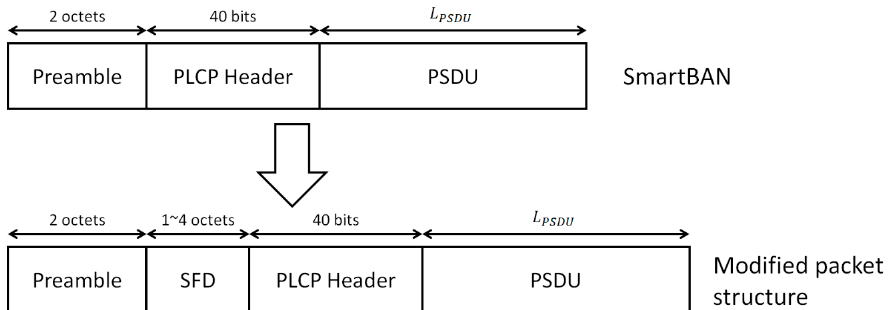
Figure 6. Block diagram of PHY transmitter.